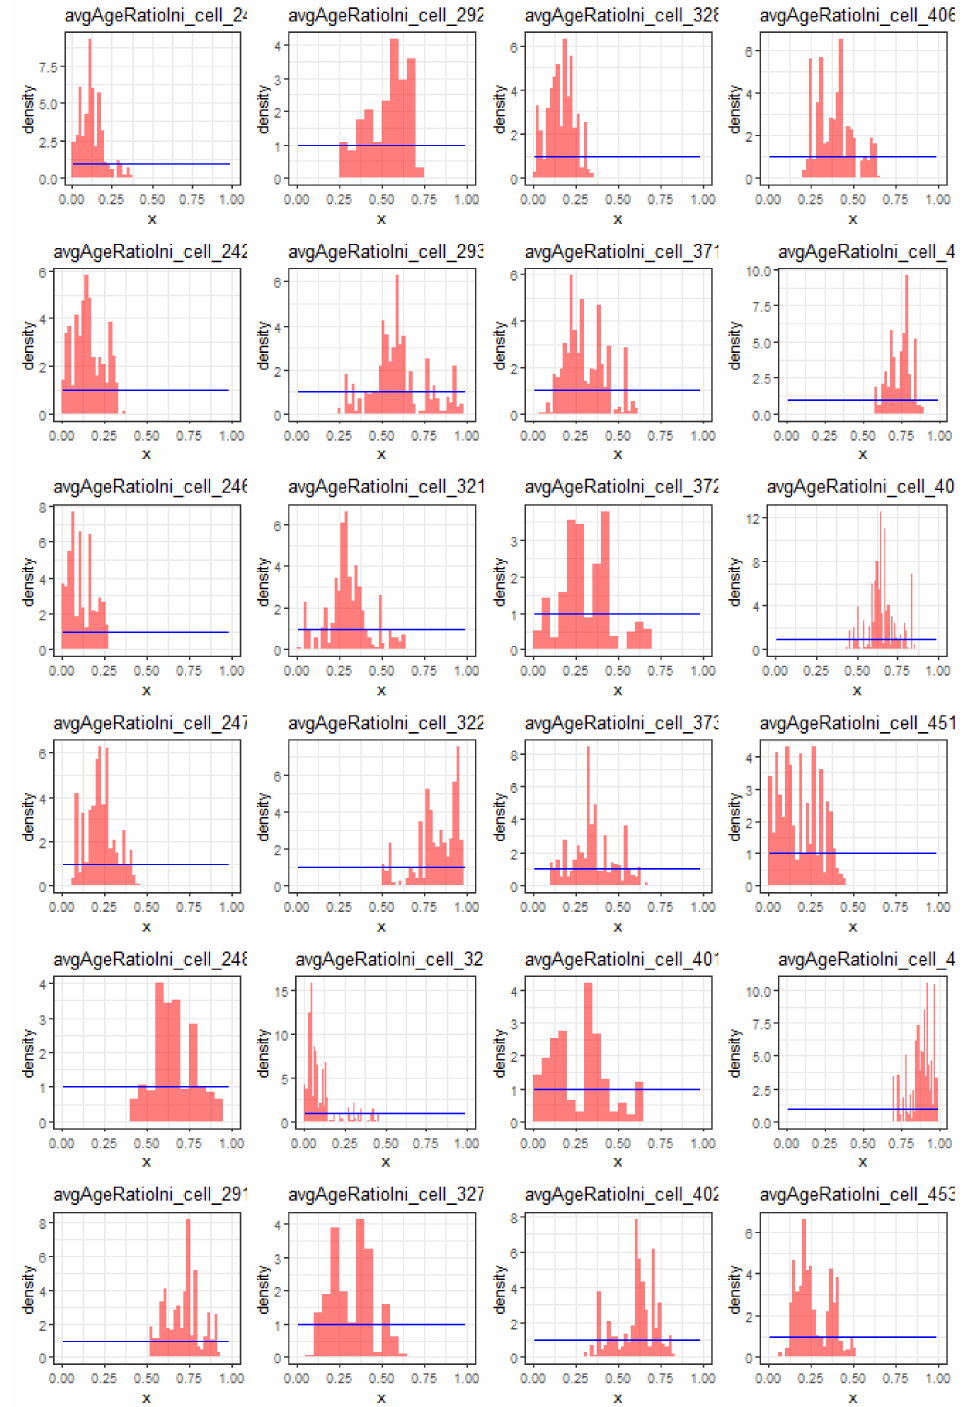
Figure A6. Posterior sample density (red histogram) and prior density (blue curve) for the mean age of the initial population ( ageRatio ) of each introduction cell. The mean posterior sample value of a cell is used as the cell value in Figure 1—bottom of the main